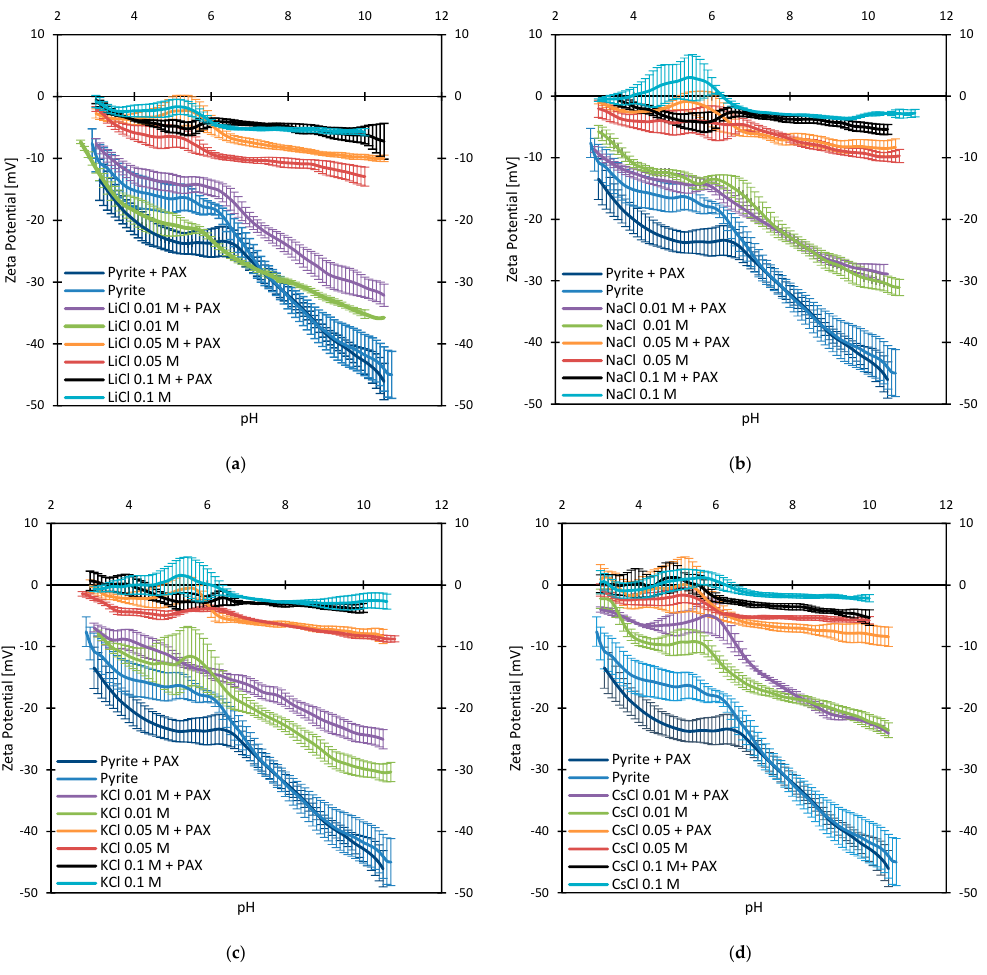
Figure 4. Zeta potential of pyrite as function of pH for different chloride salts of the monovalent alkaline metal series and concentrations with and without amyl xanthate (PAX). ( a ) LiCl, ( b ) NaCl, ( c ) KCl, and ( d ) CsCl. The concentration of PAX is always 10 − 4 M. Label Pyrite is omitted in curves for salts. Minerals 2019 , 9, x FOR PEER REVIEW